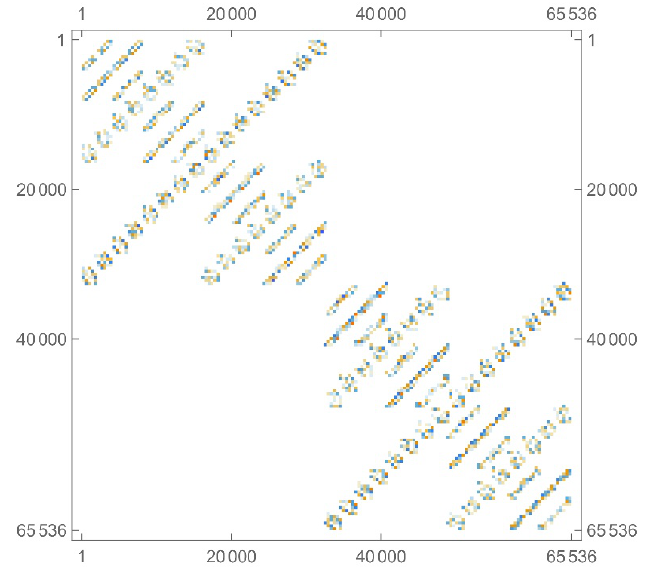
Figure 15 . The hamiltonian of the GW model in the block diagonal